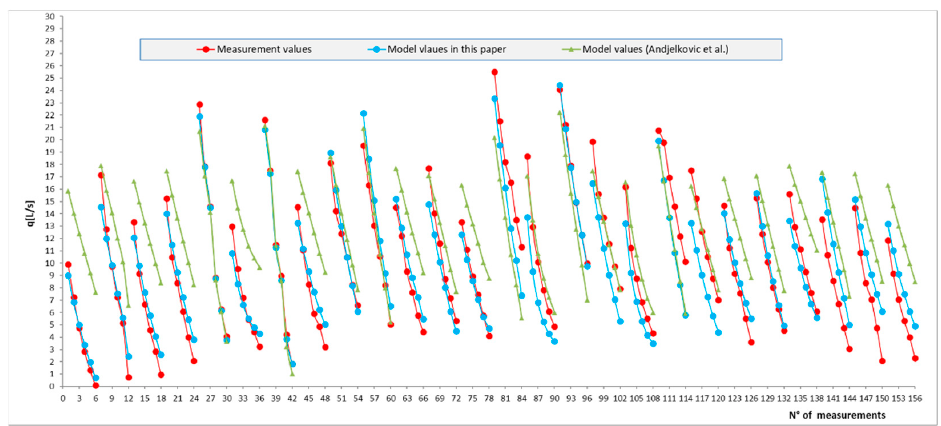
Model (10) adopted in this paper